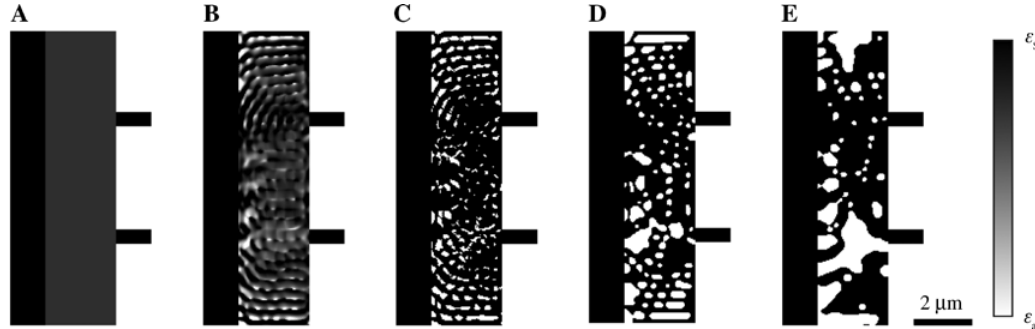
Figure 2: Structures of the designed focused wavelength demultiplexers, where black represents silicon, white represents air and gray indicates that the permittivity is between air and